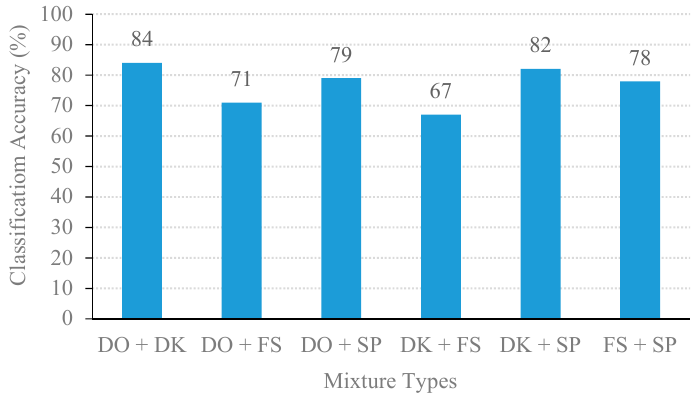
Figure 10. Classification performance of NSSEC model with 1.5 s block size.